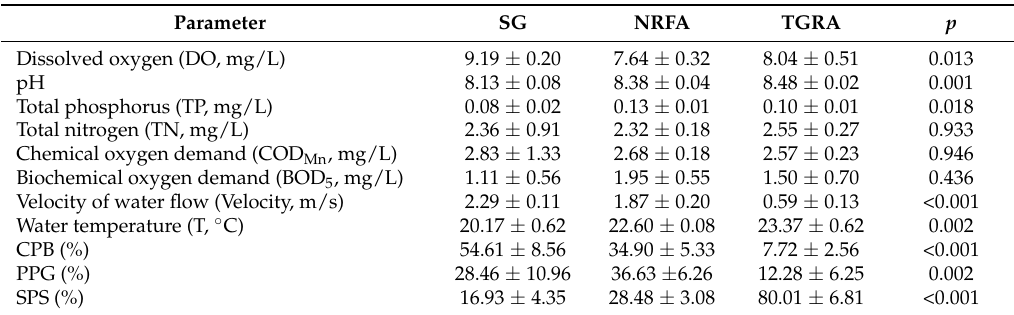
Table 2. Comparisons of the mean values of various physical and chemical parameters among the three habitat types (spawning ground (SG), natural riverine feeding and nursery area (NRFA) and Three Gorges Reservoir area (TGRA)).